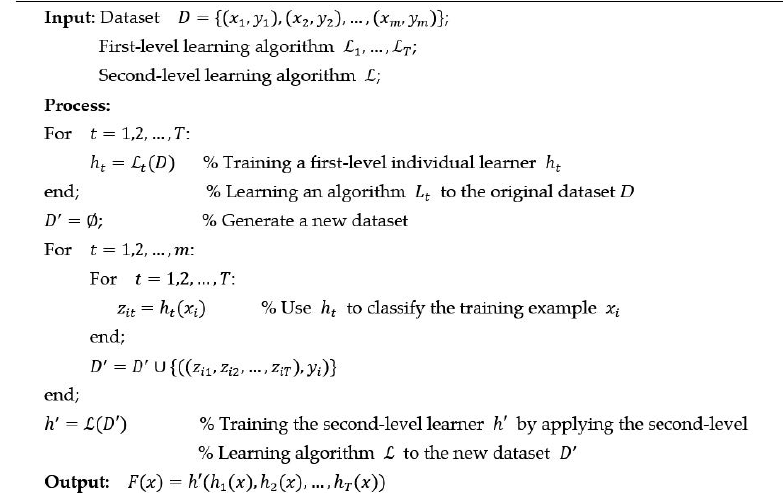
Figure 7. Histogram-based decision tree algorithm.